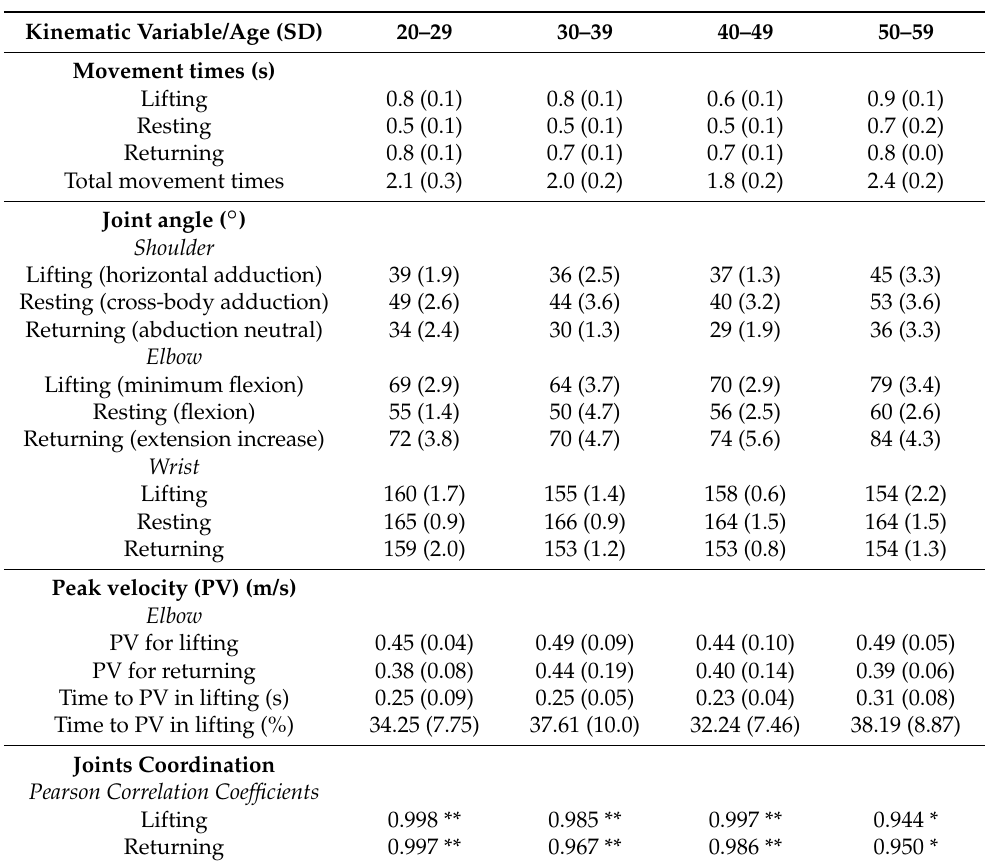
Table 3. Kinematic variables for normal subjects by age